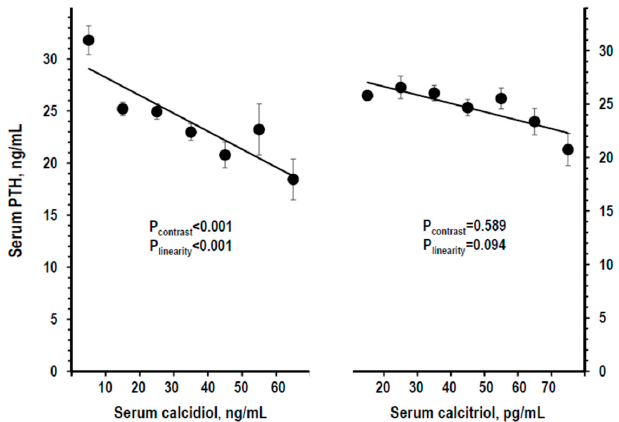
Figure 3. Mean ± SE of serum PTH by stratum of serum calcidiol and of serum calcitriol (left and right